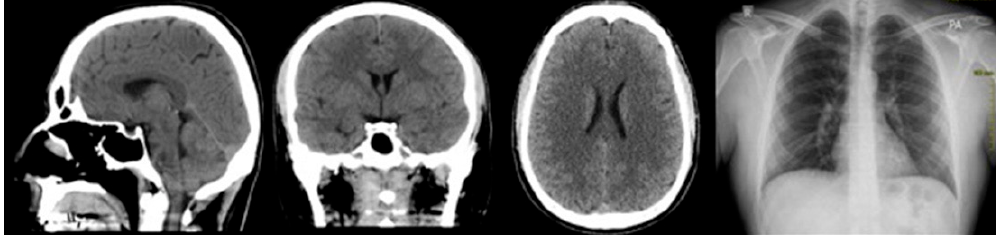
Fig. 1. CT scan and chest X-ray of a case with neurobrucellosis related to the consumption of unpasteurized camel milk. CT scan and chest X-ray showed no